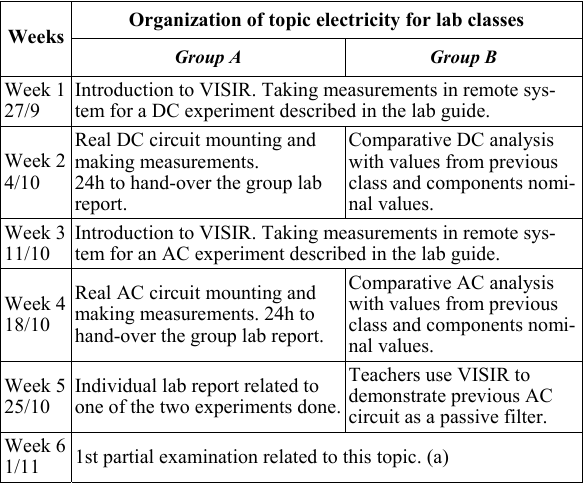
TABLE I. L ABORATORY CLASSES PLAN FOR TOPIC ON ELECTRICITY . Organization of topic electricity for lab classes